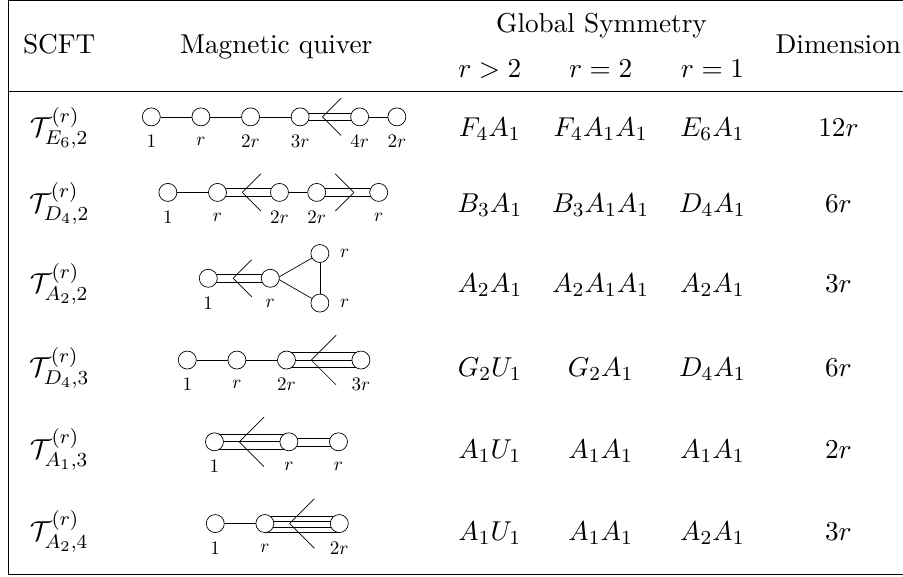
theories with r ≥ 1 . The Higgs branch Table 2. Proposal for the magnetic quivers of the T ( r ) G,‘ dimension of T ( r ) is reproduced by the Coulomb branch dimension of the magnetic quiver. The G,‘ folding parameter ‘ also indicates the multiplicity of the non-simply laced edge. In addition, the magnetic quivers display the expected symmetry enhancement for r = 2 [4]. For r = 1 the magnetic quivers describe the moduli space of one G instanton on H , naturally including the center of mass, = I (1) T (1) ⊗ H , and the global symmetry is further enhanced. Recall that a U(1) is ungauged on G G,‘ a long node for all the